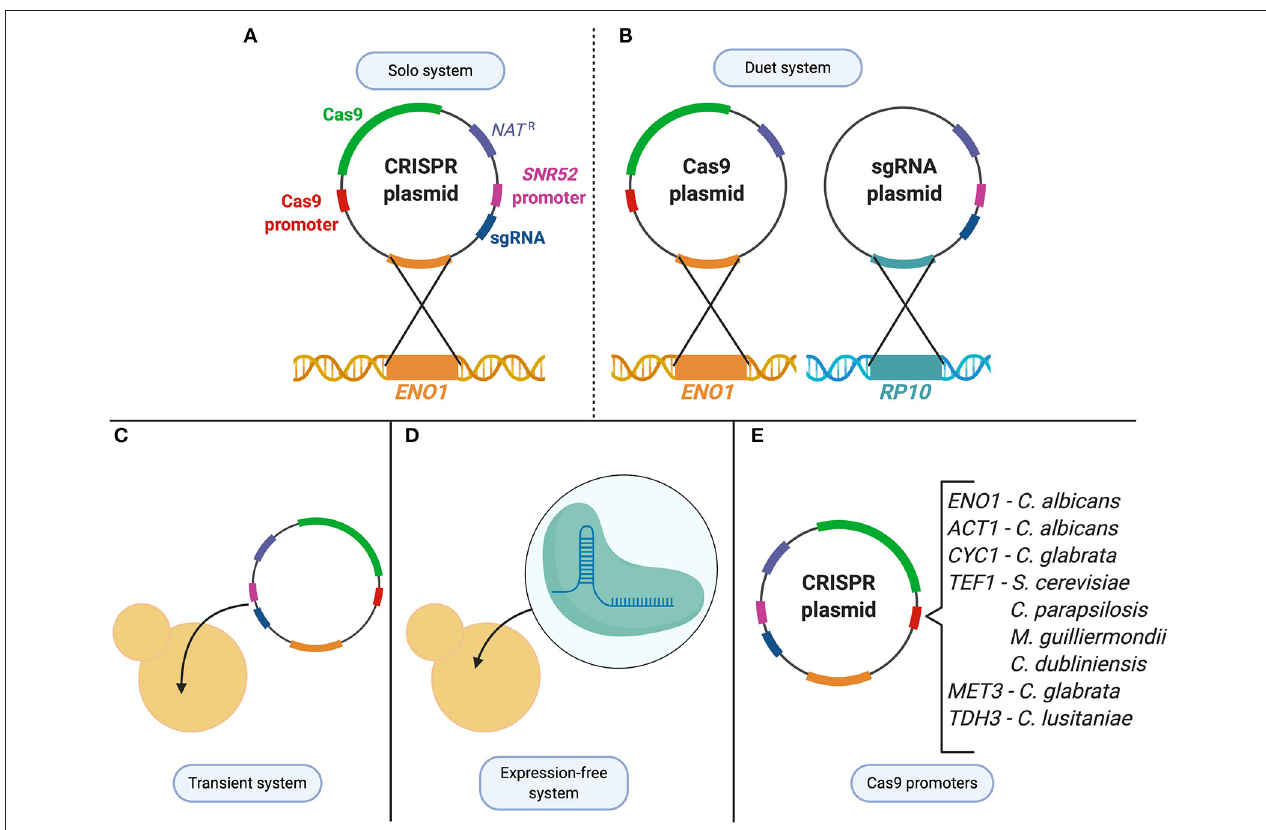
FIGURE 2 | CRISPR technologies used to study Candida species. (A) C. albicans solo system consists of a single CRISPR plasmid that contains both the Cas9 enzyme and the sgRNA which is then integrated at the ENO1 locus. (B) C. albicans duet system in which the CRISPR system is divided into two plasmids and integrated at two different loci ( ENO1 and RP10 ). (C) Transient system used in C. albicans, C. lusitaniae, C. glabrata, and C. tropicalis as an alternative expression method to integration of the CRISPR system. (D) To avoid changes to the expression system from species to species, an expression-free system, in which purified Cas9 and CRISPR RNAs are complexed to form ribonucleoproteins (RNPs), can be transformed into the cell. (E) Cas9 expression controlled under various promoters depending on the species it is being applied